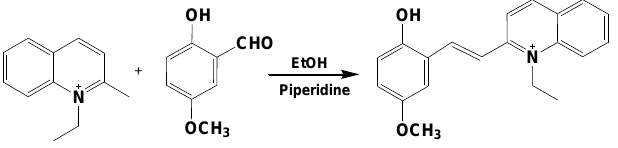
Scheme 2. Synthetic procedure of L-ol